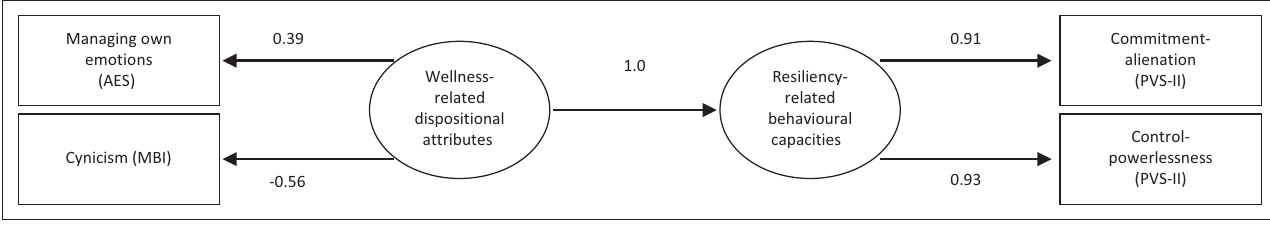
AIC = 19.22; BIC = 54.92. The best fit model is in line with the observations made in terms of the canonical correlation analyses about the best predictors of each construct. Figure 1 specifies the standardised path coefficients between the wellness-related dispositional attributes construct and